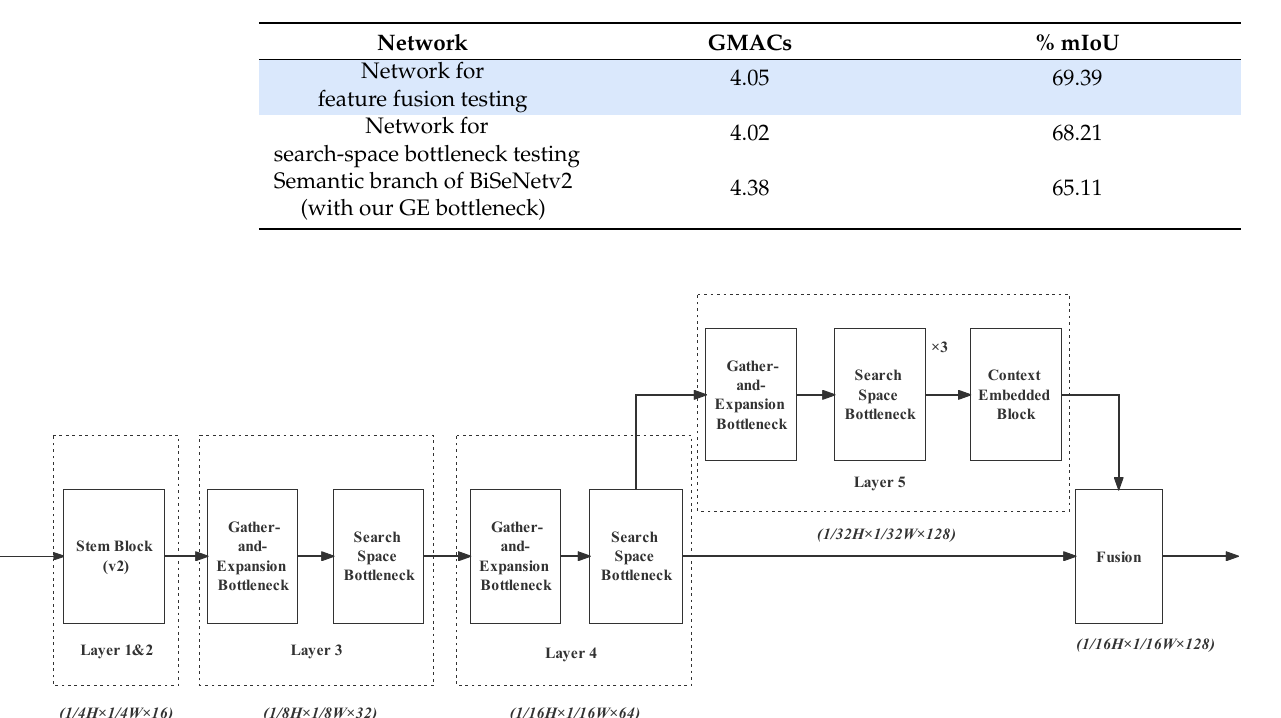
Table 6. Performance of feature fusion.